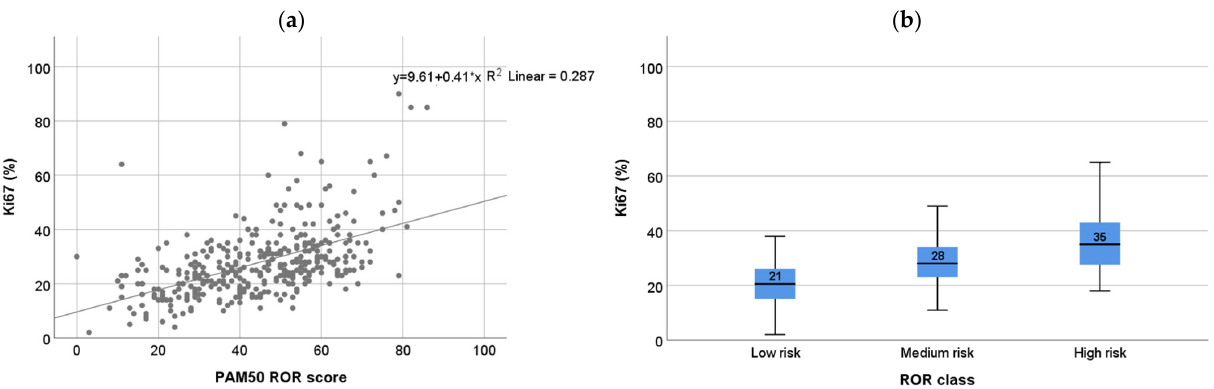
Figure 1. Correlation between Ki67 and ROR ( a ) Ki67% versus Prosigna risk of recurrence (ROR) score; Spearman correlation: rho = 0.555 ( p < 0.001, n = 360); ( b ) Ki67% in ROR risk class (low 0–40, medium, 41–60, high 61–100); Mann–Whitney p < 0.001 between all groups.